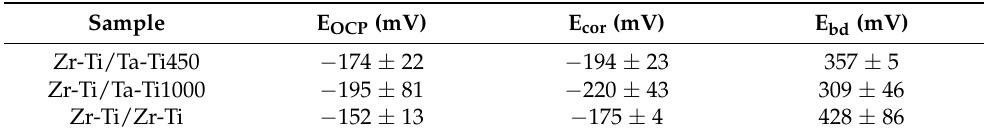
Table 3. Electrochemical corrosion investigations results. All potentials are reported with respect to